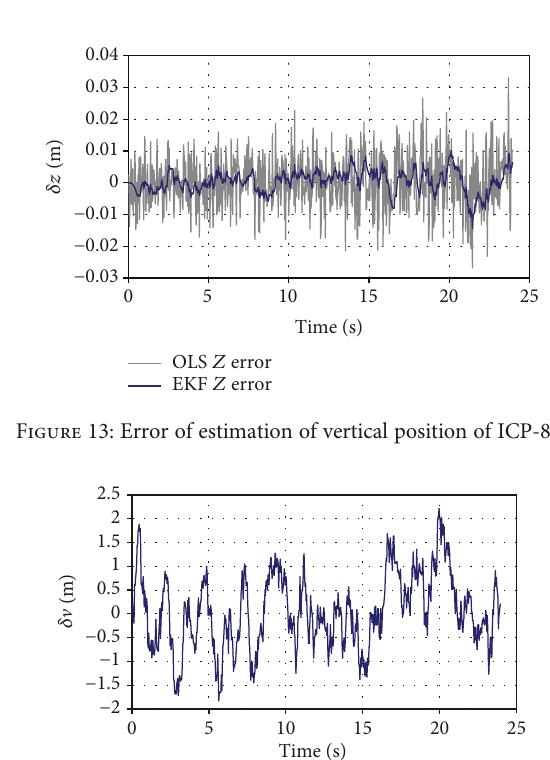
Figure 12: Error of estimation of horizontal position of ICP-89.